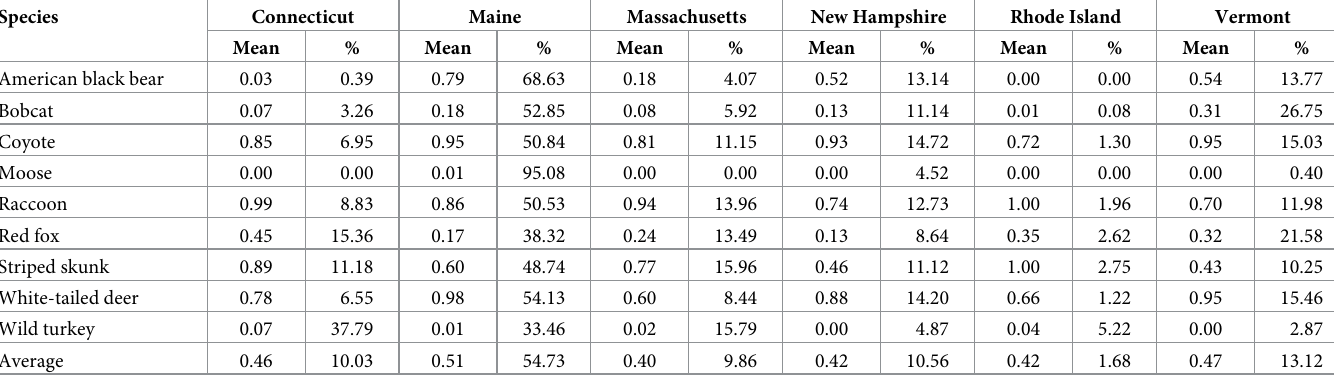
Statistics were calculated from species binary resistance maps developed for the region and provide measures for 1) Mean resistance: the proportion of the state where species occurrence is resistant to change between 2010 and 2060, and 2) Percent of regional resistance: the percentage of a species regional resistance that occurs within each